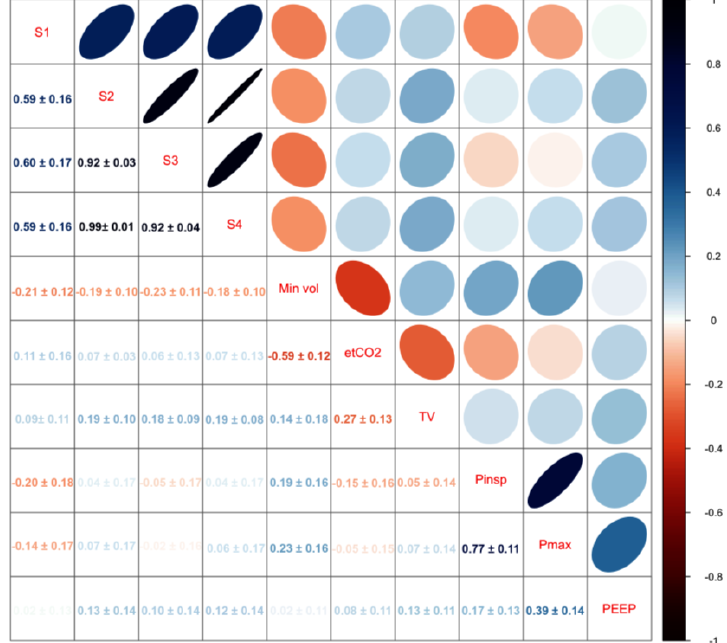
Figure 5. Correlation between ventilator variables and Sensors 1–4. Values indicate mean fixed effect regression coefficients ± their 95% confidence intervals. Blue indicates positive correlation while red indicates negative correlation. Darker more elliptical shapes indicate greater correlation.